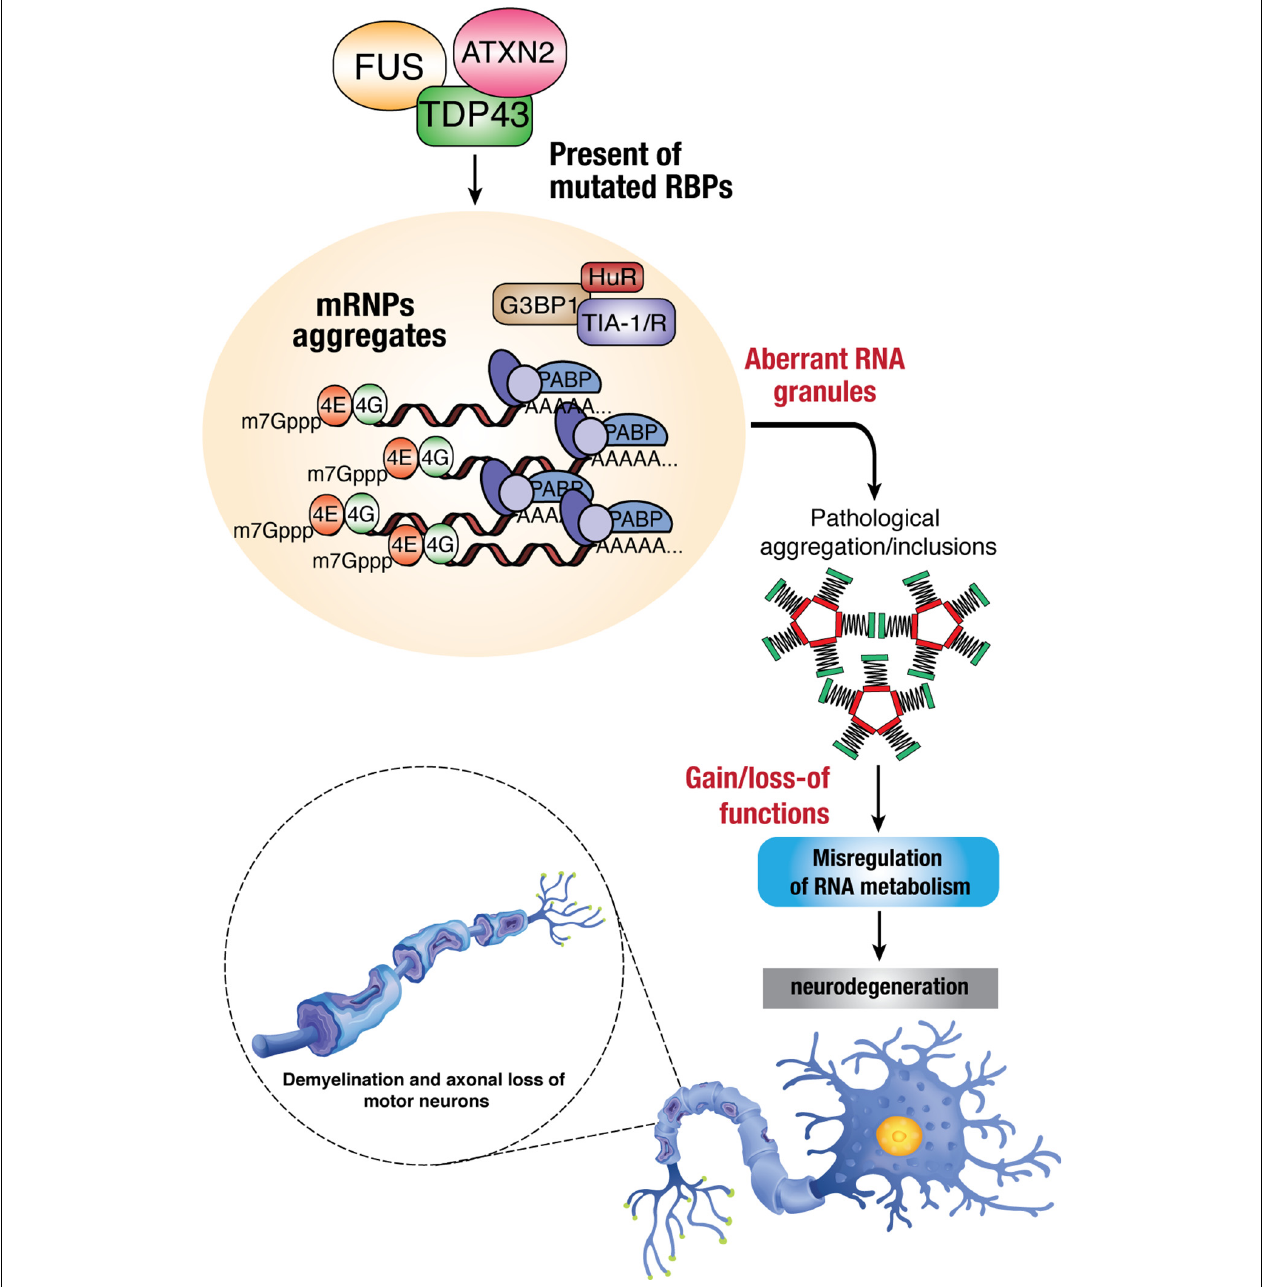
FIGURE 2 | Dysregulation of RBPs in ALS. Mutations in RBPs may result in mislocalization within the cells due to disruption in nucleocytoplasmic trafficking, which can lead to the formation of toxic protein aggregates within cytoplasmic inclusions. The accumulation of these aberrant RNA granules enhances the toxicity/pathological effects in mis-regulating normal RNA metabolism and thus leading to neurodegenerative phenotypes such as demyelination, axonal loss, and death of motor